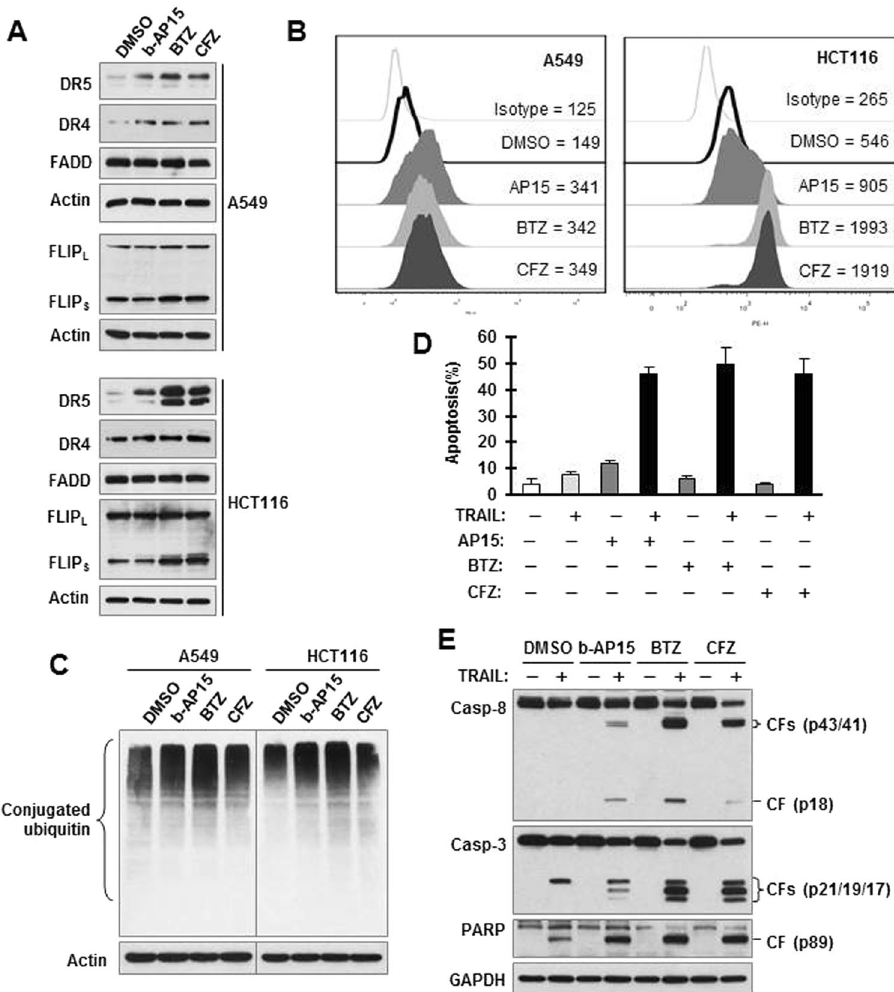
Figure 6. b-AP15 functions similarly to proteasome inhibitors in elevating DR5 levels ( A and B ), accumulating conjugated ubiquitin ( C ) and enhancing TRAIL-induced apoptosis ( D and E ). ( A–C ) The indicated cell lines were exposed to 0.5 μ M b-AP15, 0.1 μ M BTZ, or 0.1 μ M CFZ for 8 h ( A and C ) or 10 h ( B ) and then harvested for detection of different proteins and protein polyubiquitination with Western blotting ( A and C ) or for detection of cell surface DR5 with flow cytometry ( B ). The numbers inside ( B ) are MFIs of DR5 staining. ( D and E ) A549 cells were exposed to 0.5 μ M b-AP15, 0.1 μ M BTZ, or 0.1 μ M CFZ alone, 50 ng/ml TRAIL alone, or their respective combinations for 10 h or 20 h and then harvested to detect apoptosis with annexin V staining/ flow cytometry ( D ) and to detect the cleavage of caspases and PARP with Western blotting ( E ). The data in ( D ) are means ± SDs of triplicate determinations. CF, cleaved fragment. Full-length blots/gels are presented in Supplementary Figure